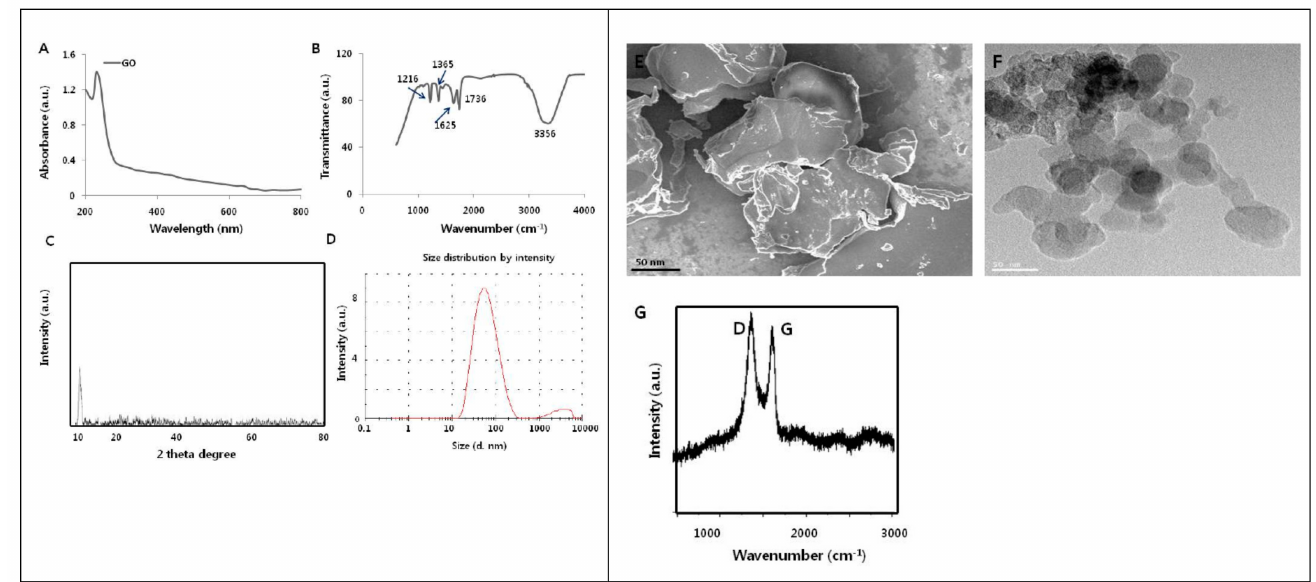
Figure 13. Schematic representation of the various characterizations of graphene oxide. ( A ) UV– visible spectrum, ( B ) FTIR spectrum, ( C ) X-ray diffraction images, ( D ) dynamic light-scattering analysis, ( E ) scanning electron microscopy, ( F ) transmission electron microscopy, ( G ) Raman spectrum [Reprinted with permission from ref. [164], Gurunathan, S.; Arsalan Iqbal, M.; Qasim, M.; Park,